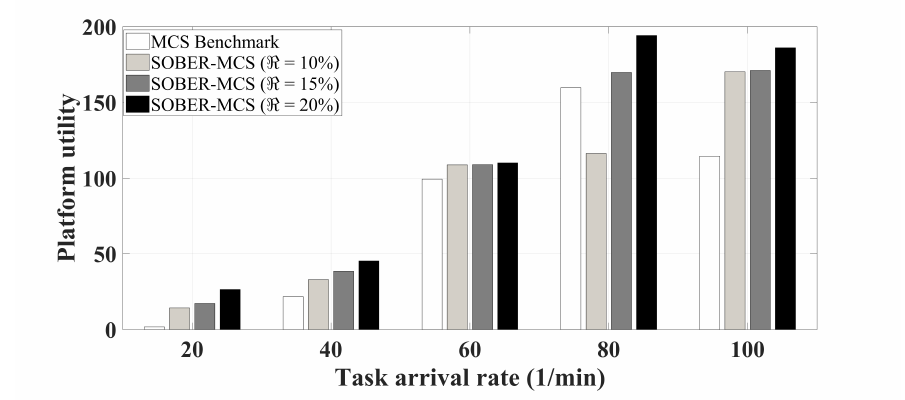
Figure 9. Platform utility. SOBER-MCS, Sociability-Oriented and Battery-Efficient Recruitment for Mobile Crowd-Sensing.